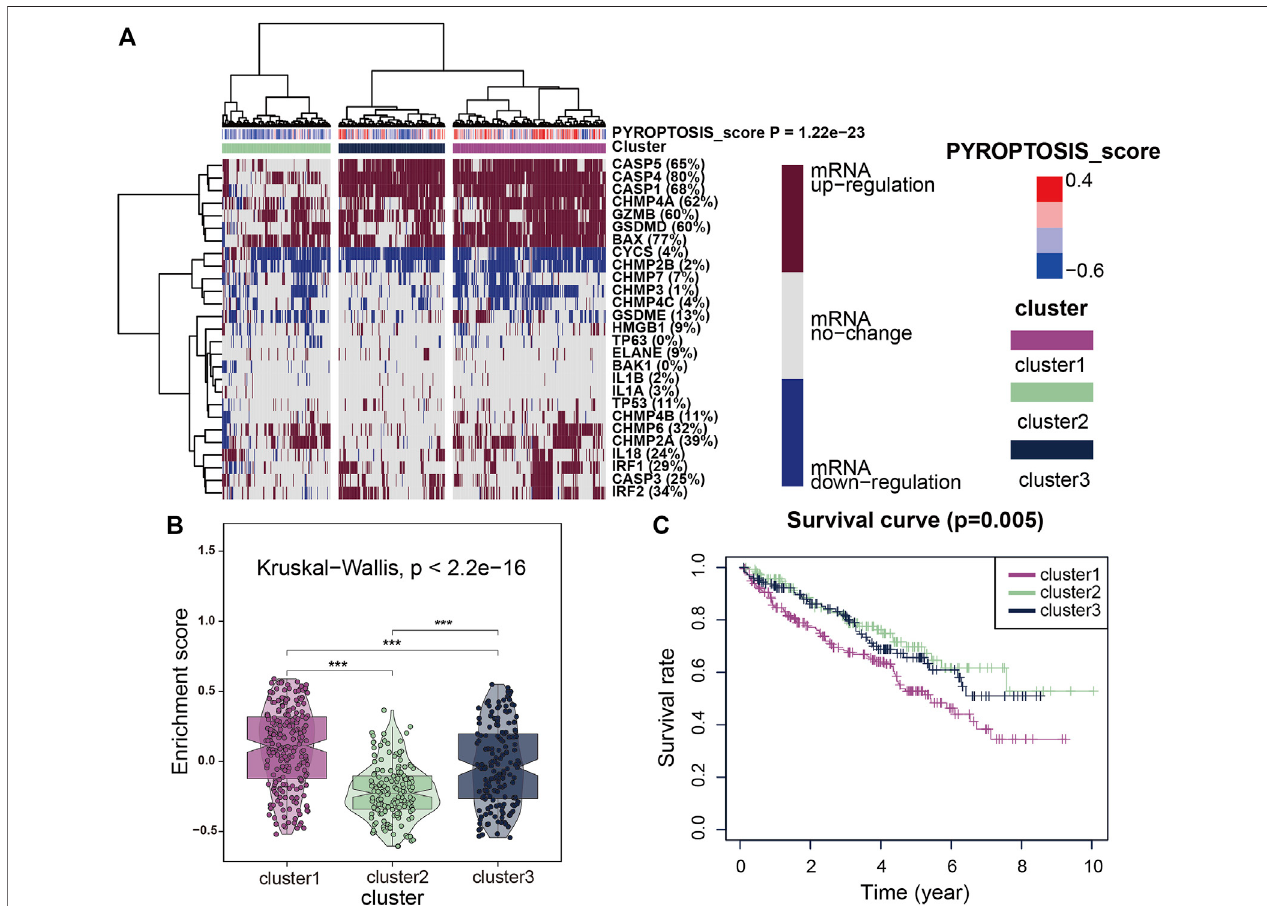
pyroptosis genes, including CNV ( Figures 1A,B ), SNV ( Figure 1C ), and mRNA expression ( Figure 1D ) levels. In general, genetic mutations of pyroptosis are widely present in most cancer types, except for individual cancers such as THCA, SARC, SKCM, and other non-obvious mutations in pyroptosis-related genes. Correlation analysis of gene expression and the survival landscape ( Figure 1E ) indicated that pyroptosis-related genes were most closely associated with KIRC, and most of the genes were risk factors in patients with KIRC. The survival curve ( Figure 1F ) also indicated that high expression of most pyroptosis-related genes was correlated with poor patient prognosis. Differences in methylation of pyroptosis- related genes in KIRC were extensive, and most were related to differences in mRNA expression ( Figures 1G,H